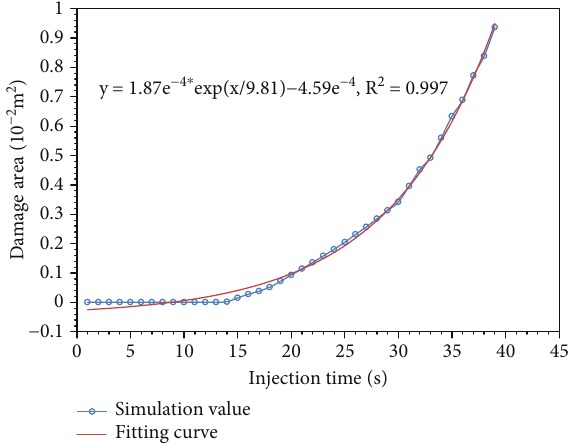
Figure 15: Development of the seepage area versus injection time in the orthogonal jointed